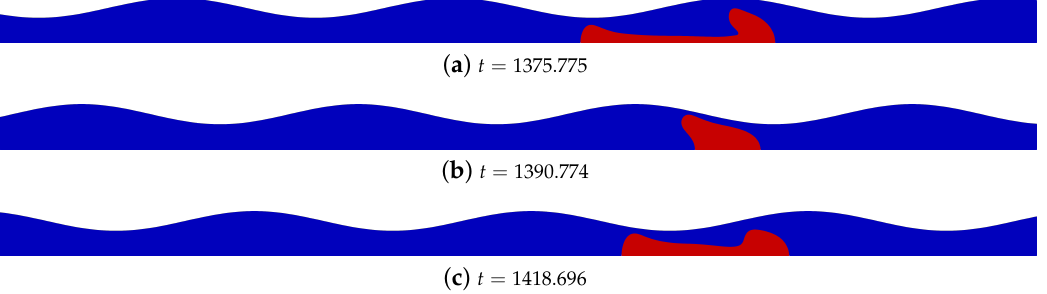
Figure 5. Single drop shape evolution with time in sinusoidal channel with amplitude A = 0.14 during its passage in one corrugated length where the drop undergoes severe topological change due to the variation of channel’s cross-sectional area. All parameters are